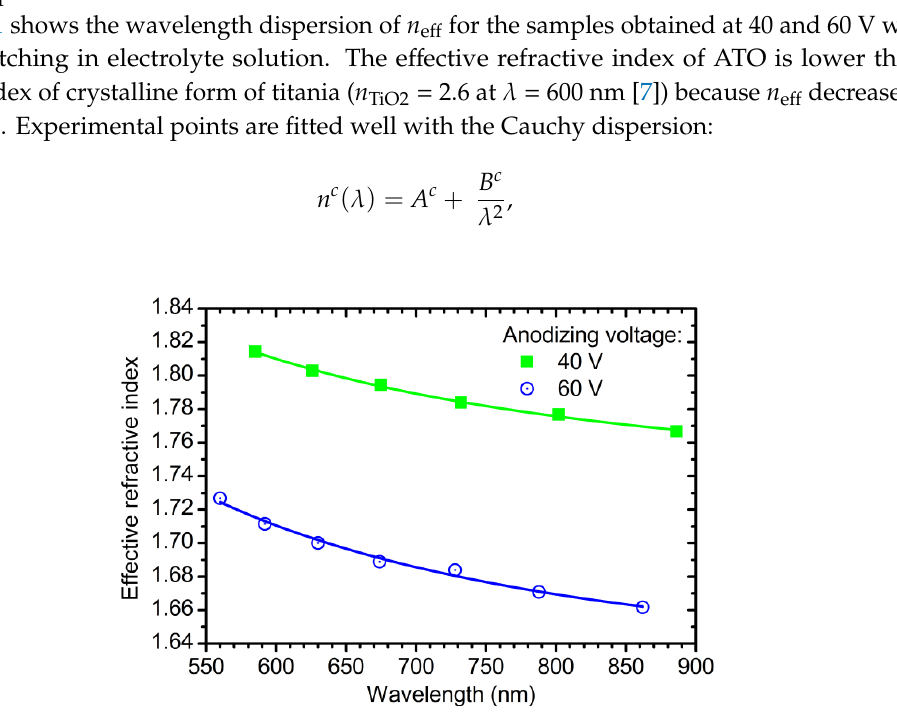
Figure 2. Dependences of the effective refractive index of the anodic titanium oxide at a wavelength of 800 nm on additional etching time in electrolyte solution. Experimental data for the samples